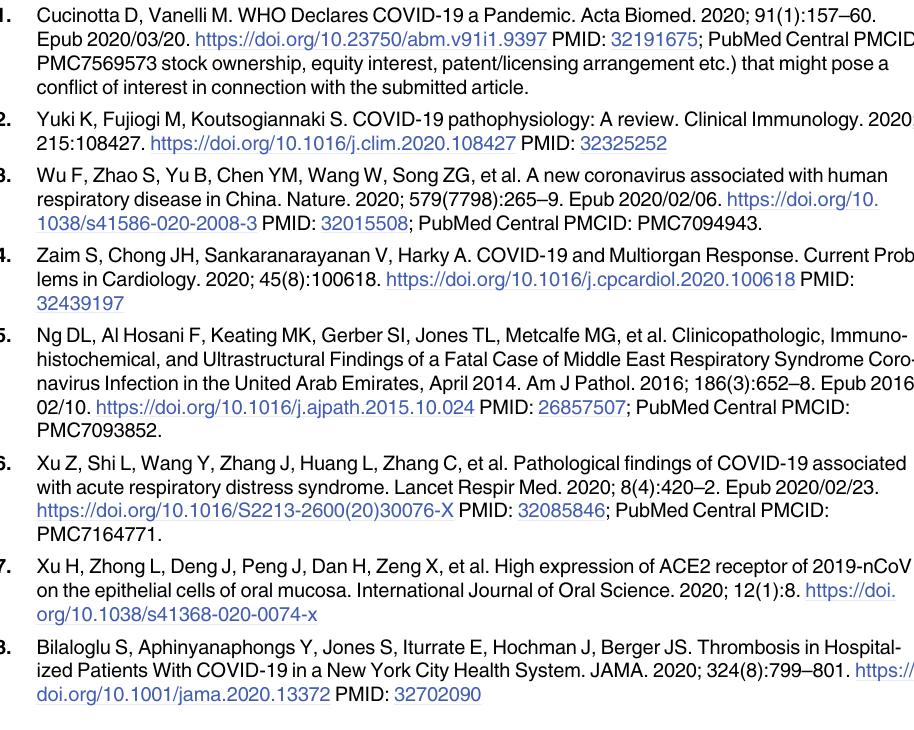
S1 Table. Murad tool—methodological quality assessment of case reports and case series. S2 Table. First author, country, study type, peer review, sample size, gender, and age of cases of the included studies. S3 Table. Classification of the histopathological findings in COVID-19